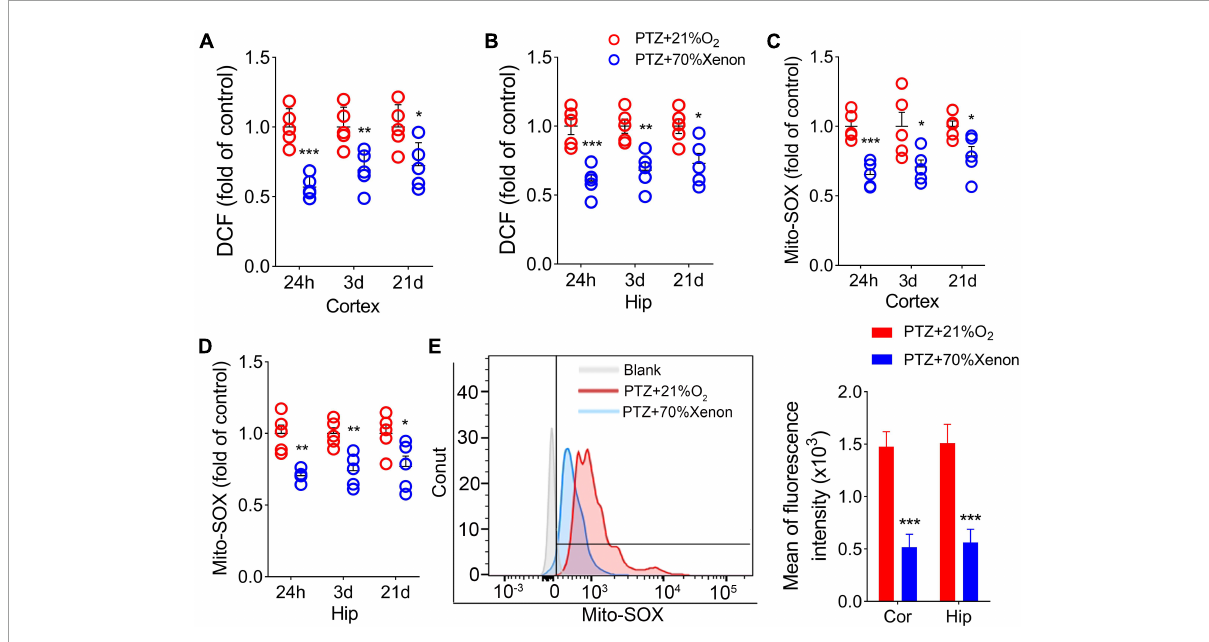
FIGURE7 Xenon treatment reduced the elevated levels of 2’,7’-dichlorodihydrofluorescein (DCF) and mito-SOX caused by pentylenetetrazole (PTZ) administration. Decreased levels of DCF (A,B) and mito-SOX (C,D) in the hippocampus and cortex due to xenon treatment ( n = 5/group). (E) Flow cytometry-based quantification of hippocampal mito-SOX levels. * P < 0.05, ** P < 0.01, and *** P < 0.001, compared with controls (unpaired T